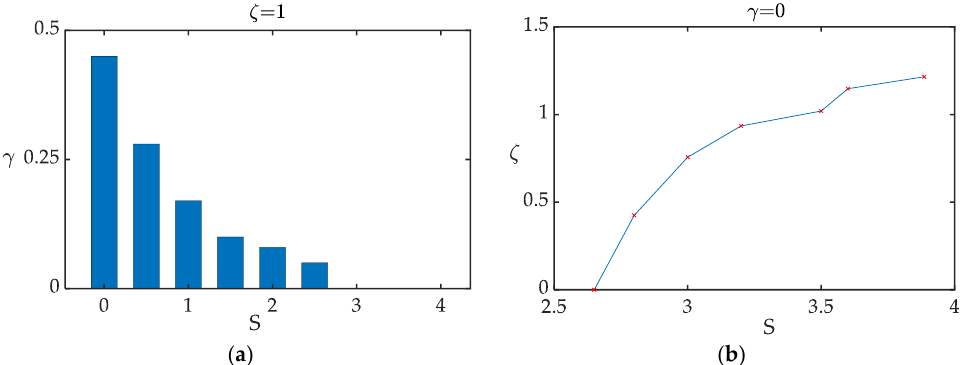
Figure 11. The marginal evaluation results. ( a ) Exclusion ratio for sampled scaling factors at marginal value 𝜁 = 1 ( b ) Achievable marginal requirement.